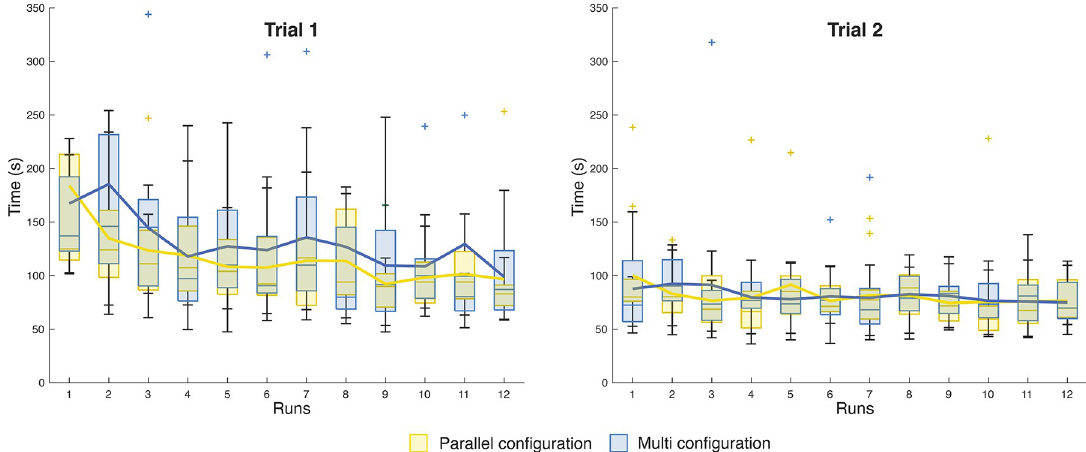
Fig 9. Box and whisker plots of the average time per run in the two trials performed by each participant for each instrument. Yellow represents the parallel configuration (PC), and blue the multi configuration (MC). Each box and whisker plot represents the median, the upper and the bottom quartile of the average time for 12 participants. The outliers above 350 s have been cut off in the figure. The full picture can be found in the supplementary